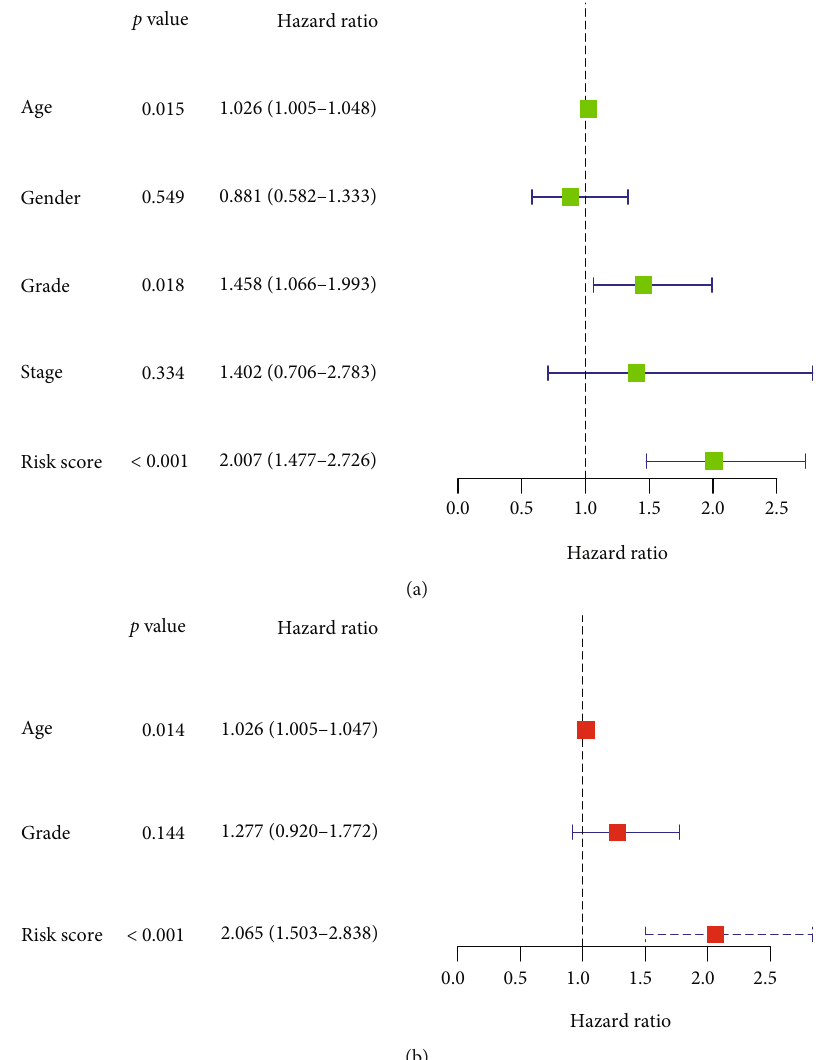
Figure 5: (a) Univariate and (b) multivariate assays of the relevancy between several clinical elements and overall survival of PAAD